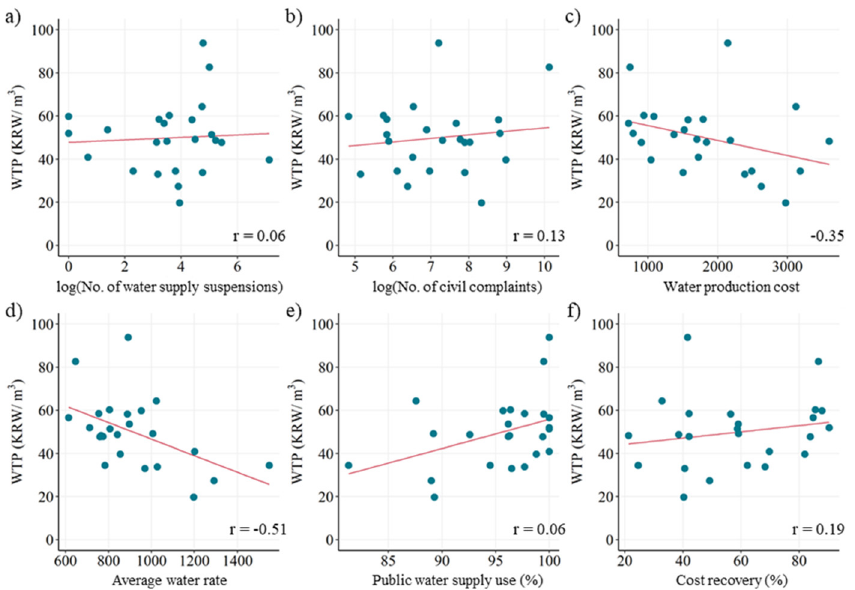
Figure 5. Correlations between county-level WTPs and water supply service performances: ( a ) annual number of water supply suspensions in 2018; ( b ) annual number of civil complaints in 2018; ( c ) water production cost (KRW/m 3 ); ( d ) average water rate (KRW/m 3 ); ( e ) public water supply use (as % of the population); and ( f ) cost recovery (%).